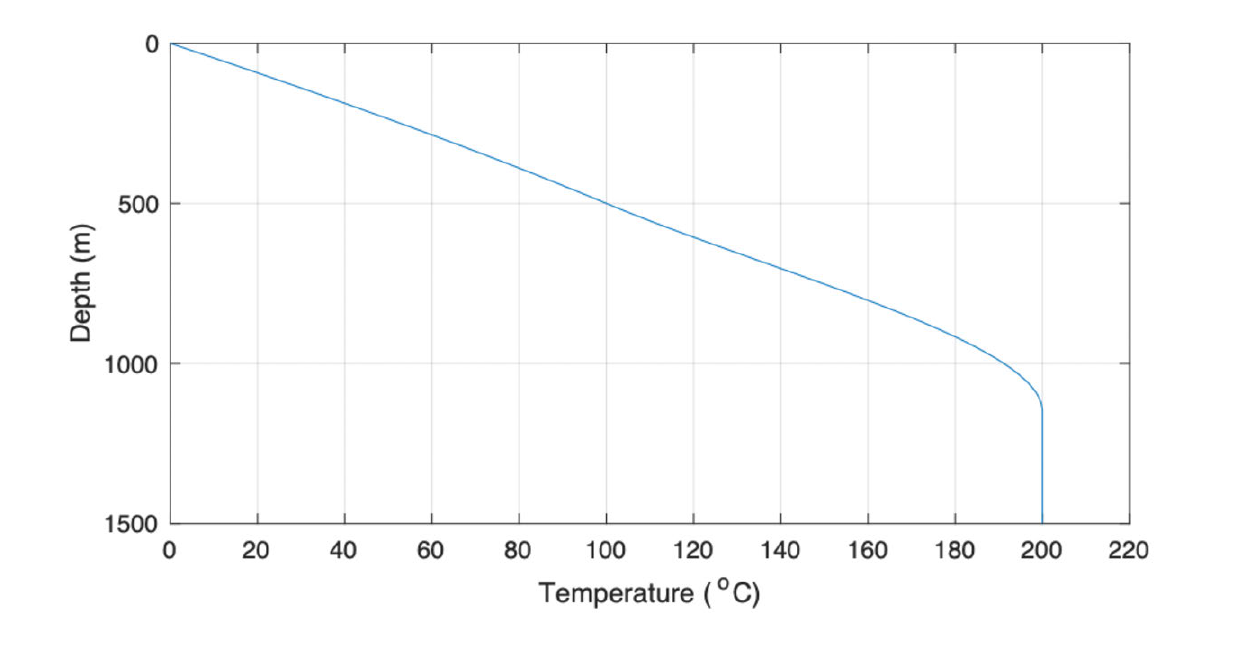
Figure D3: Initial geotherm with dT/dz = 200 °C in the upper 1000 m, and leveling out to a constant temperature of T = 200 °C below a depth of 1100 m, with a smooth transition in between.